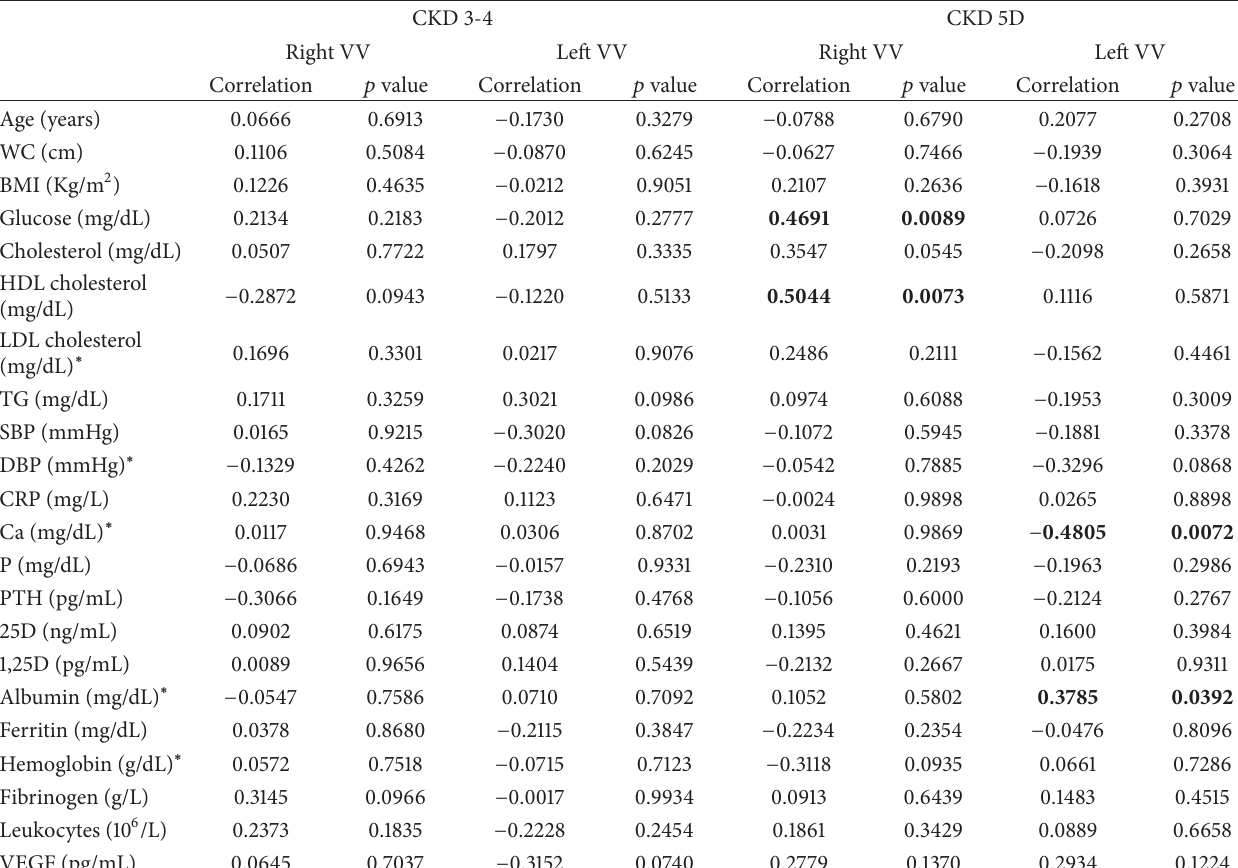
Table 3: Association between adventitial VV and biochemical and anthropometric variables in CKD